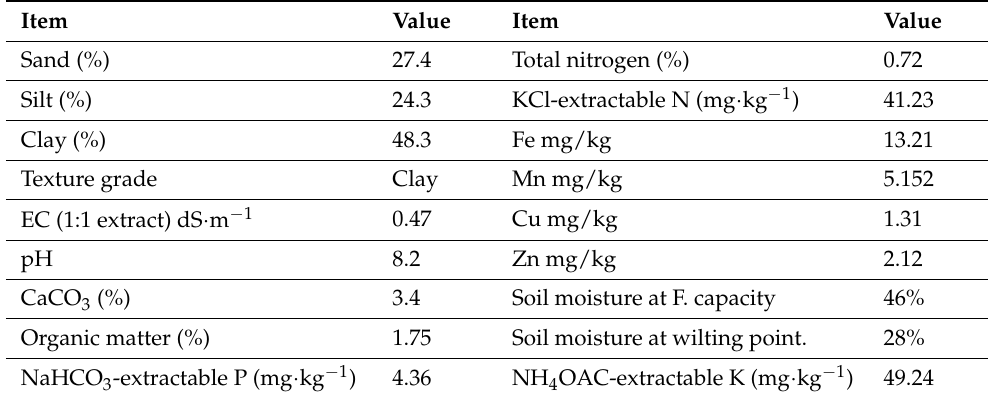
Table 5. Some physical and chemical properties of representative soil sample in the experimental sites before sowing (30 cm